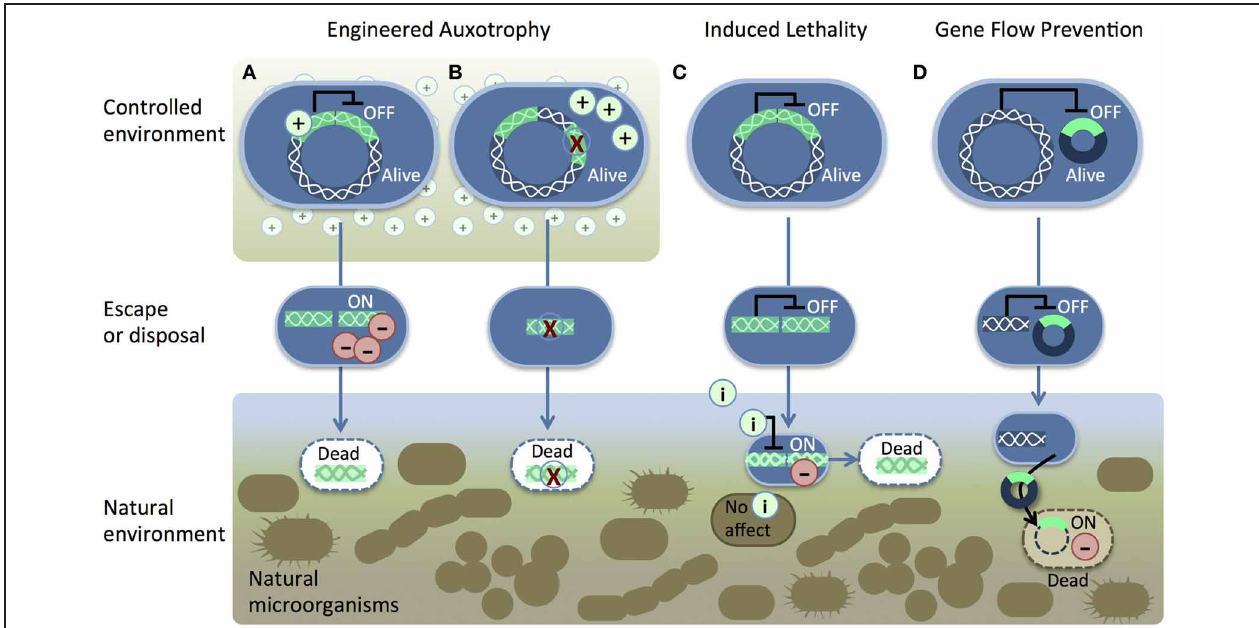
FIGURE 1 | Genetic safeguard strategies. Recombinant DNA (bright green) is introduced into the host chromosome (white wavy lines). Two pathways for engineered auxotrophy (A,B) kill synthetic organisms (blue) once they lose access to asupplement ( + )inacontrolled environment. The supplement either (A) suppresses atoxicgeneproduct ( − )or (B) provides nutrition tocompensate